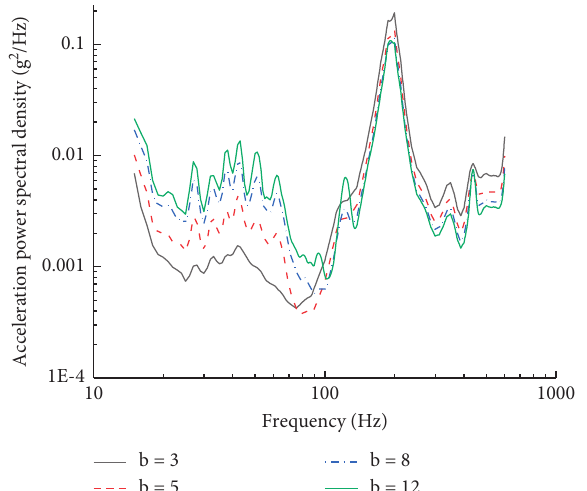
Figure 7: Comparison of PSDs obtained at different acceleration parameters (b).